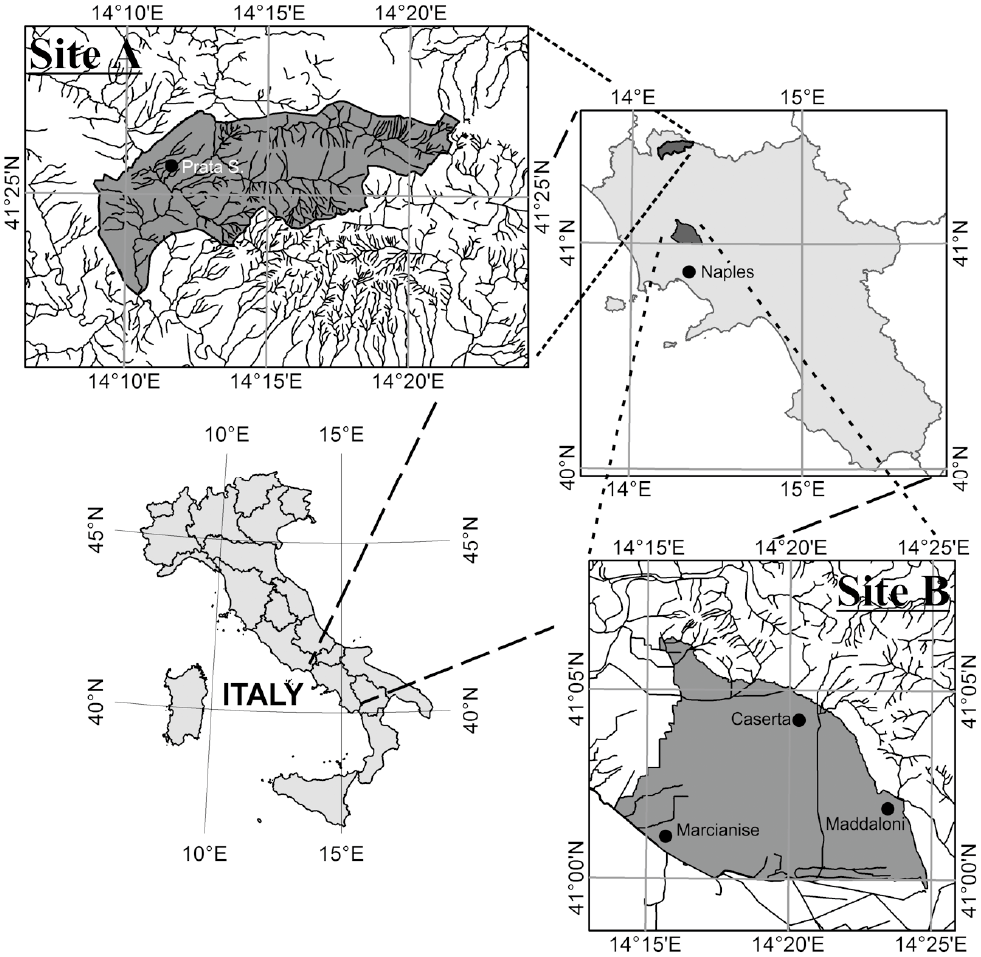
Figure 1. Location map of the study sites where Site A indicates the Lete River catchment while Site B refers to the eastern Campania Plain sector.